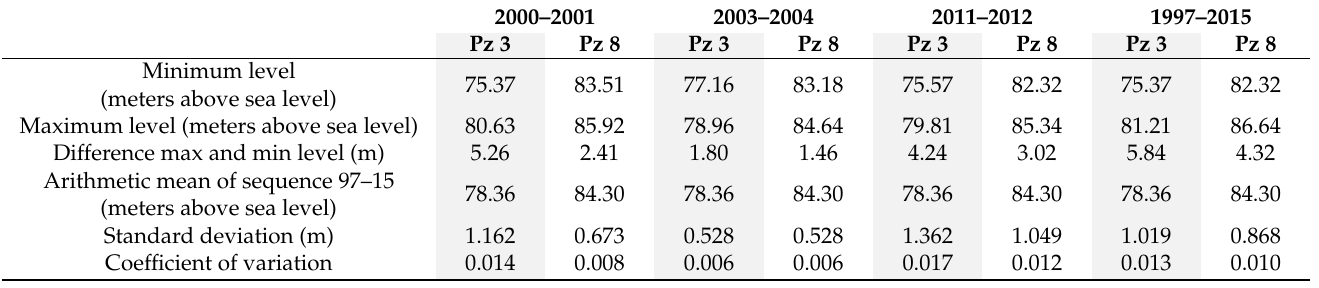
Table 2. Comparison of hydrological parameters for Pz 3 and Pz 8 in the years 2000–2001, 2003–2004,